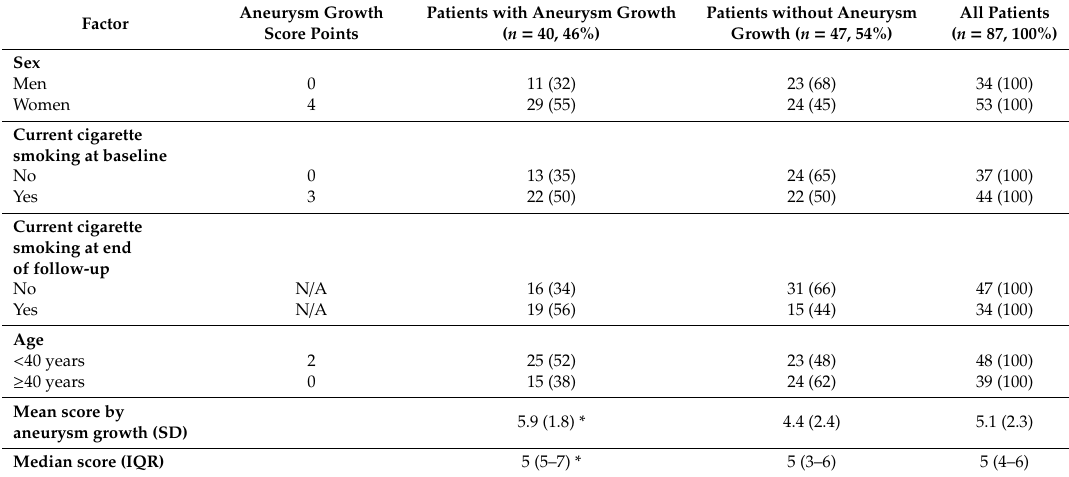
(Table 2). Odds ratio of new scoring for aneurysm growth was 1.4 per unit (95% CI, 1.1–1.8, p = 0.006). Table 2. New growth score stratified by long-term aneurysm growth. Aneurysm Growth Patients with Aneurysm Growth Patients without Aneurysm Factor Score Points ( n = 40, 46%) Growth ( n = 47, 54%)